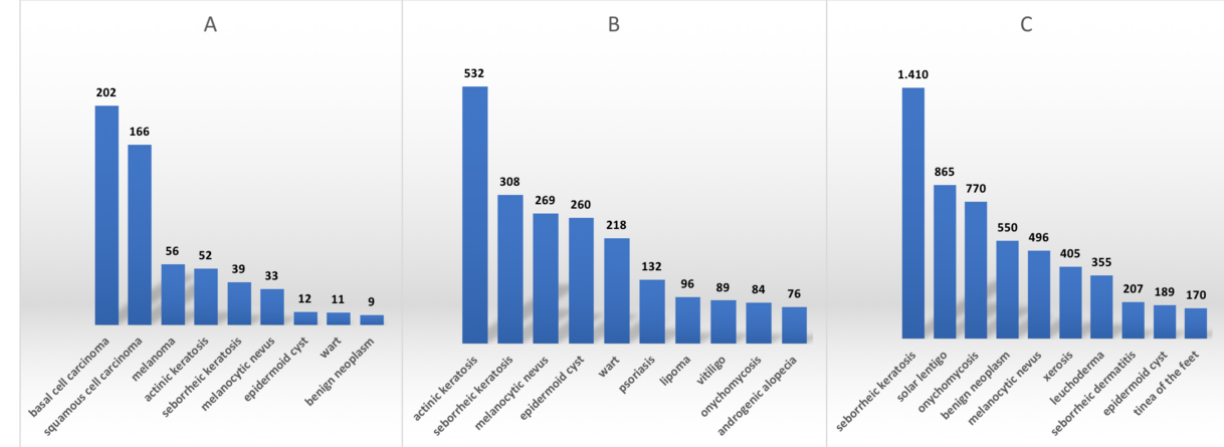
Figure 3. Most frequent lesions (n) sent to biopsy, dermatologists, and back to physician in patients aged 60 years and older who participated in the teledermatology project from July 2017 to July 2018 in São Paulo,